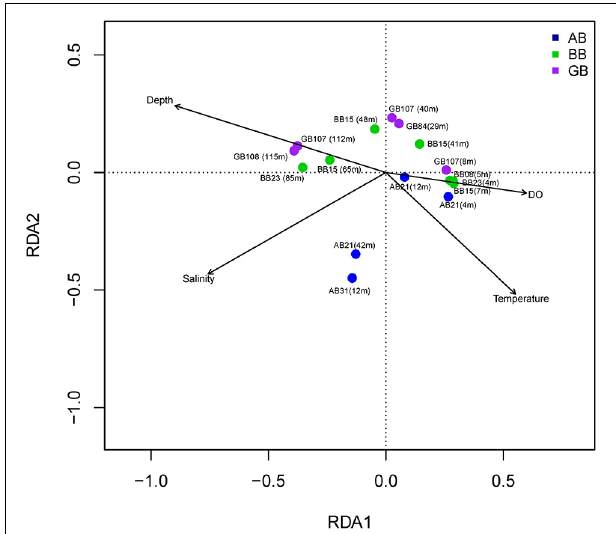
FIGURE 4 | db-RDA biplot of environmental variables and microbial community in different samples. Different samples and environmental variables are plotted on RDA axes 1 and 2. Arrows denote biplot scores for the different constraining environmental variables.